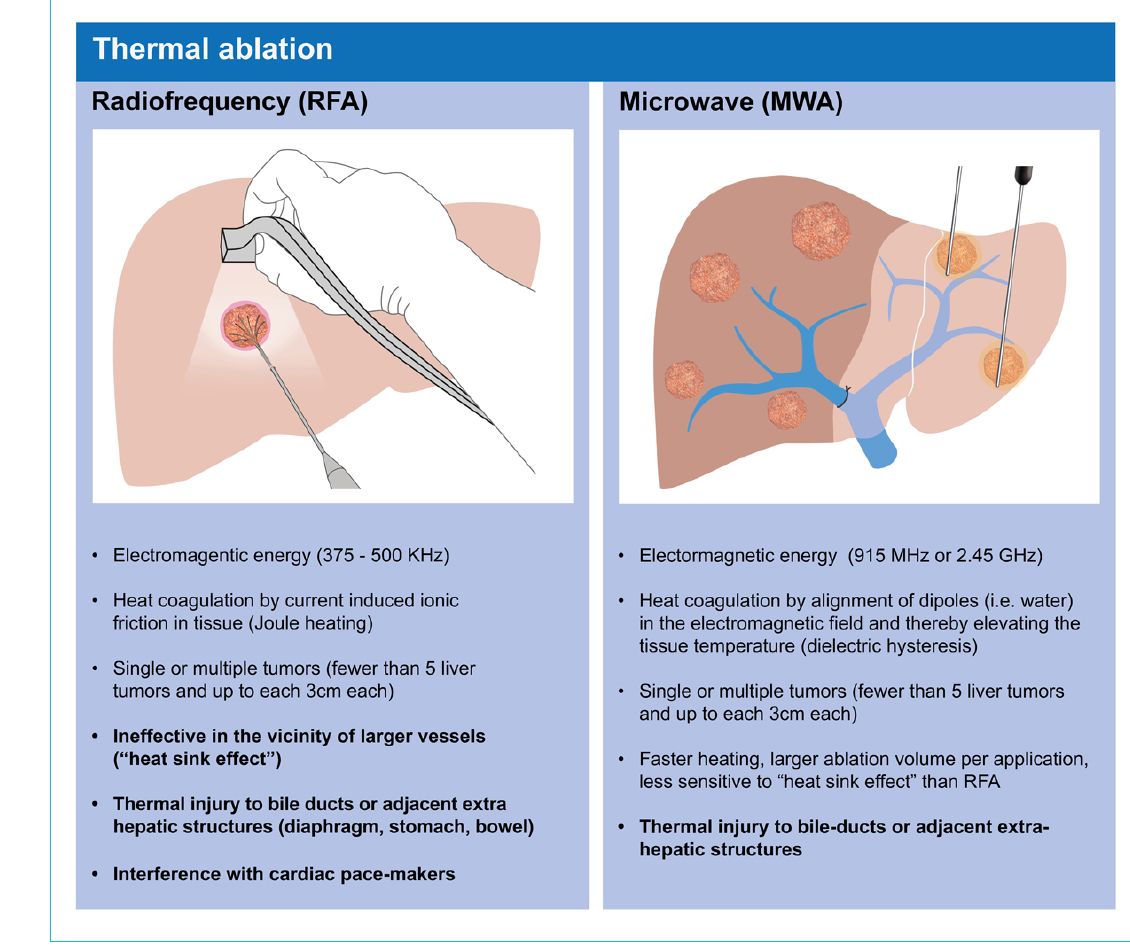
Figure 4: Radiofrequency (RFA) and microwave ablation (MWA) are the most frequently used ablative thermal modalities. Illustration: Carol De